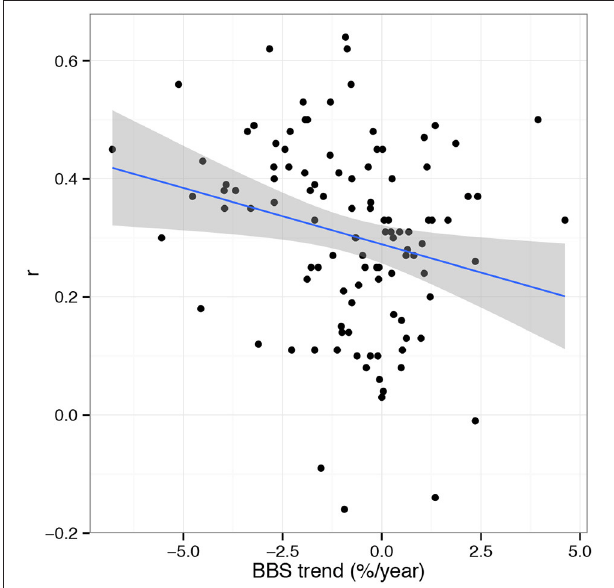
FIGURE 4 | Relationship between BBS population trend (%/year 1980–2014) and model prediction success. On average, abundance changes of declining species were better predicted than those with stable or increasing populations ( ˆ β = − 0.019 ± 0.007 SE, P = 0.021).